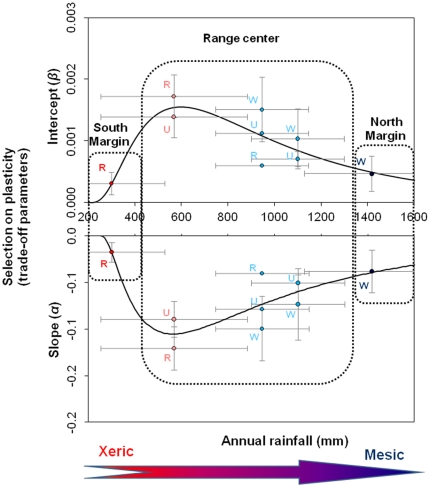
Selection pressure on the plastic trade-off across the annual rainfall gradient, calculated as the sensitivity of average fitness to potential change in the slope (α) and intercept (β) of the trade-off between seed mass and seed number.Error bars represent s.d. For the riparian habitat in the semi-arid hot and semi-wet tropical region, sensitivities are not stochastic and s.d. represents the variation between years at those sites.